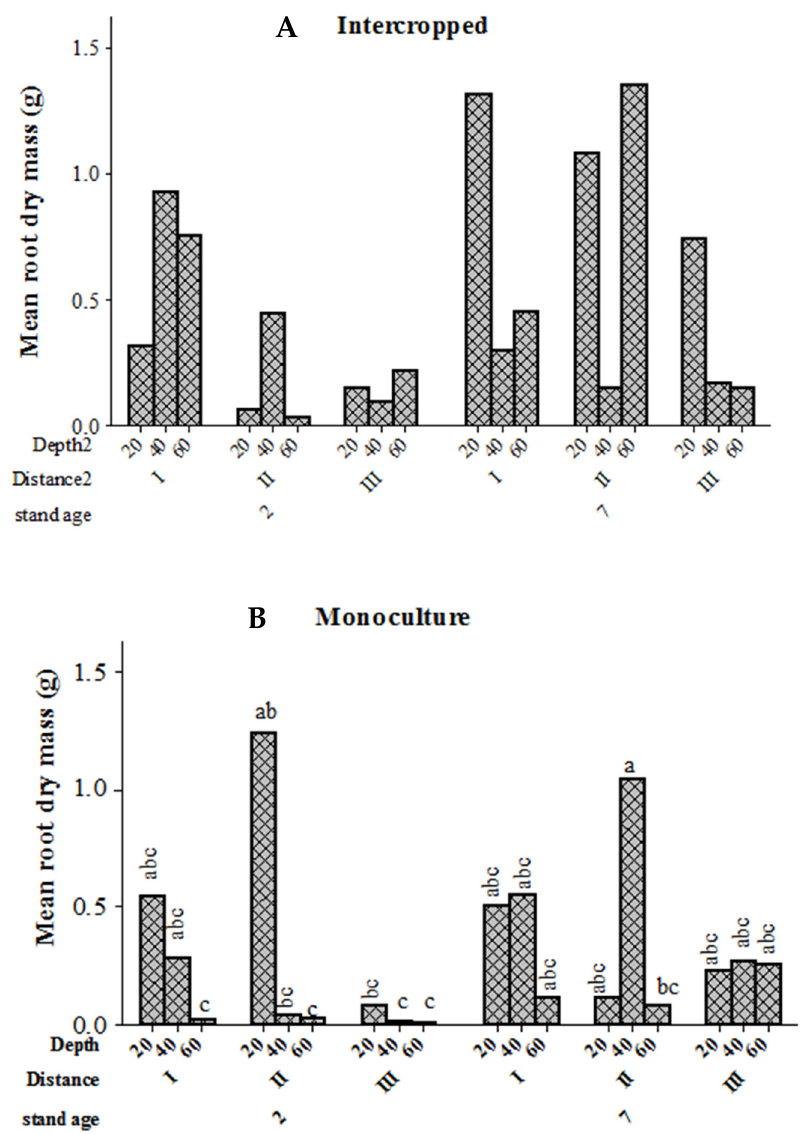
Figure 7. Mean root dry mass (g) of E. camaldulensis in relation to stand age (2 years versus 7 years old), distance from the tree, and soil depth for stands established with 9 m × 1 m spacing, which were either intercropped or pure monoculture. Bars with the same letter (s) are not significantly different at 5% probability. Intercropping ( A ), Monoculture ( B ). Table 3. ANOVA results for the effects of stand age, distance from the tree, and soil depth on root dry mass of E. camdulensis in monoculture and intercropped stands.